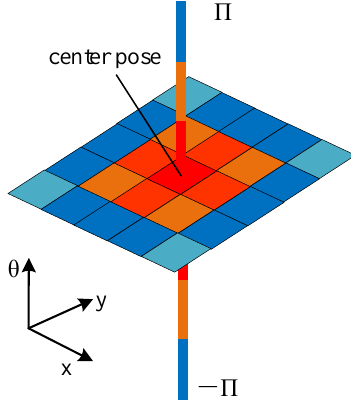
Figure 2. Schematic diagram of the set Ω Figure 2. Schematic diagram of the set  .